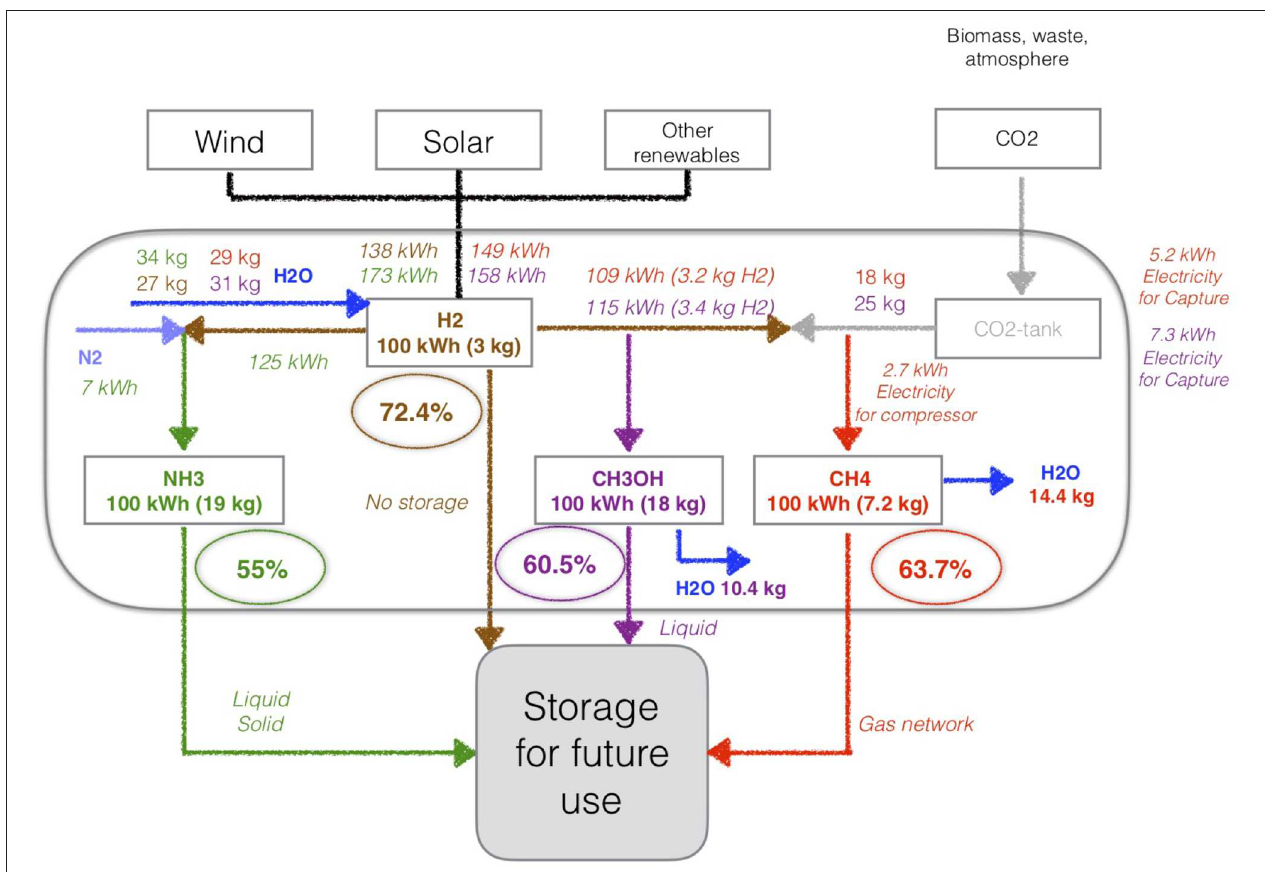
FIGURE 2 | Energy efficiency of production for hydrogen (H 2 ), methane (CH 4 ), methanol (CH 3 OH), and ammonia (NH 3 ) from the renewable energy sources—based on Connolly et al. (2015, 2016) and Matzen et al.